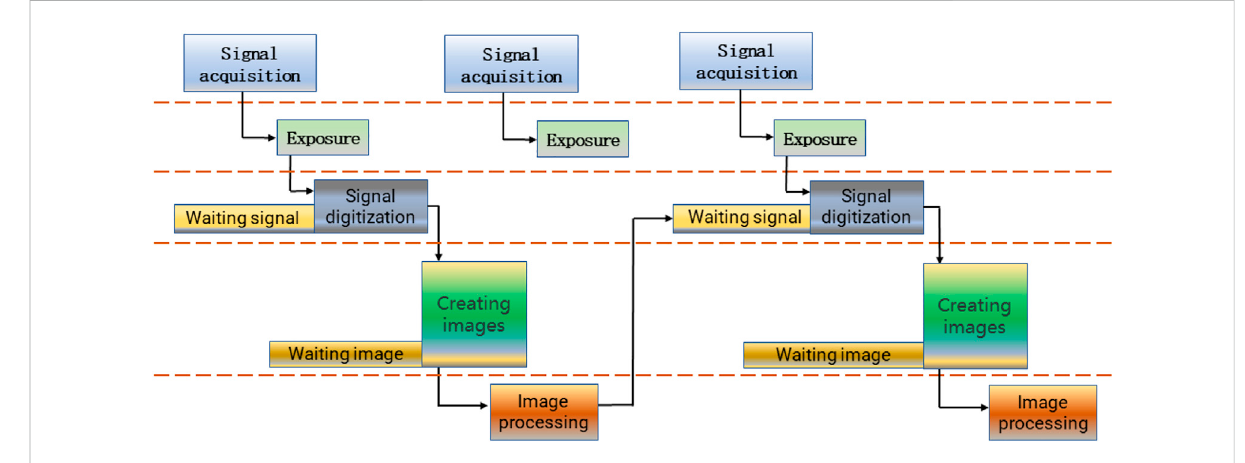
FIGURE 6 Flow chart of Synchronous acquisition.